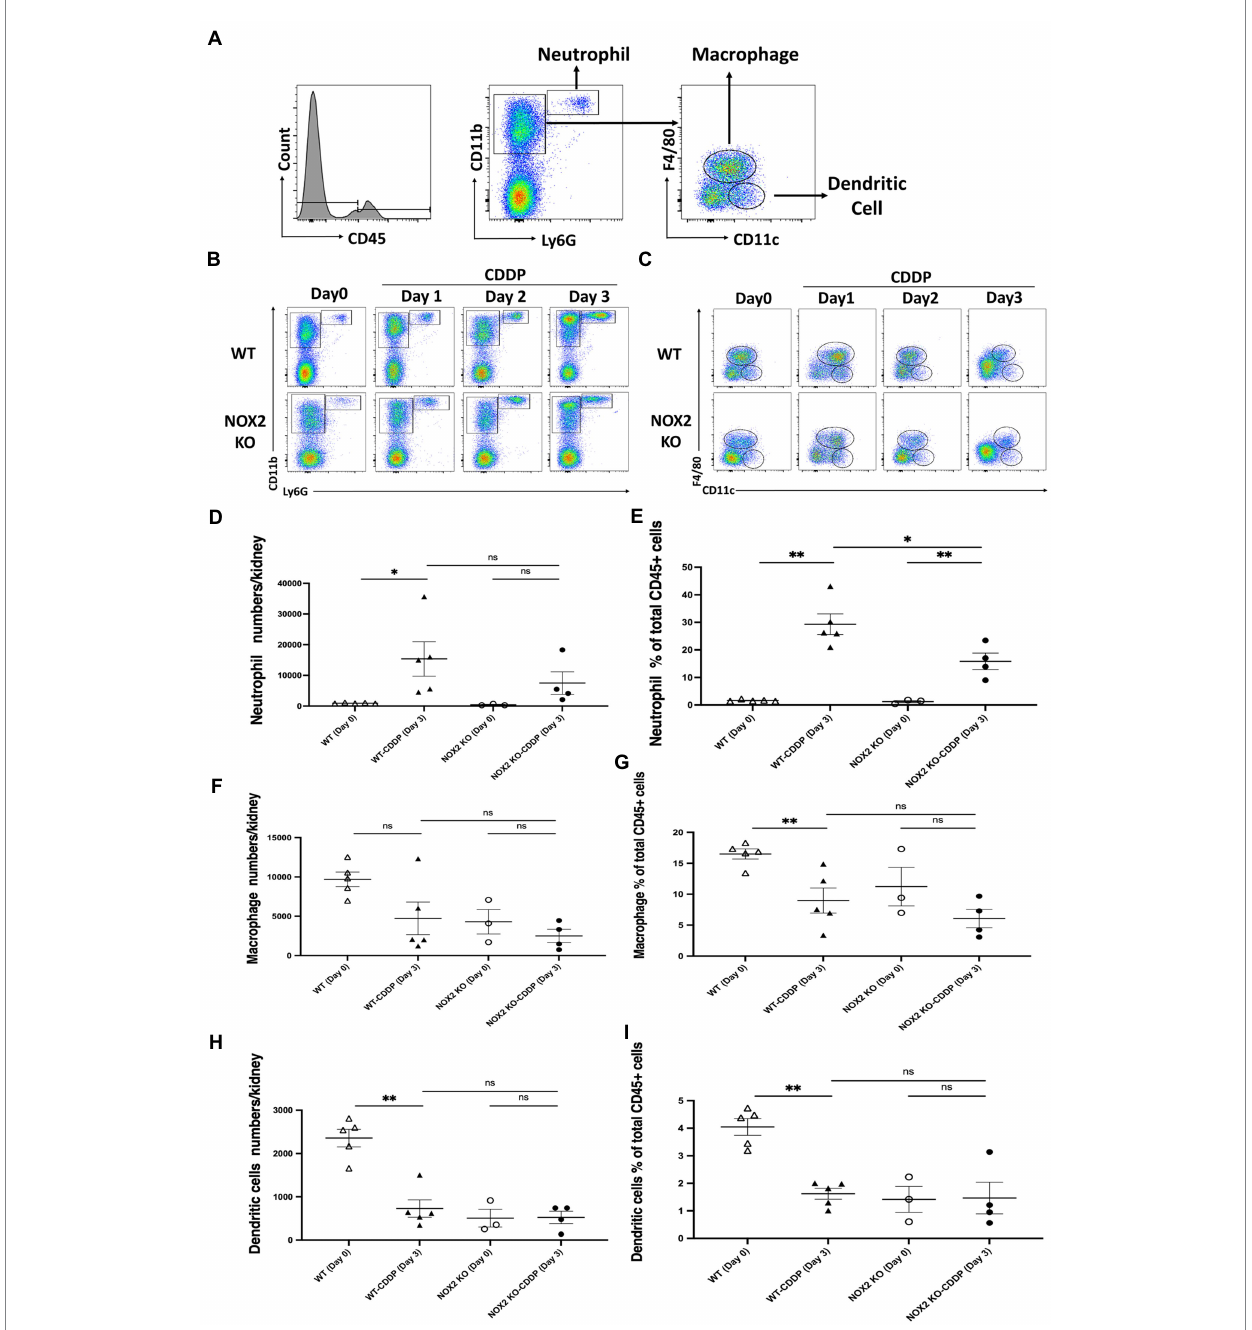
FIGURE 6 Mice with NOX2 deletion had reduced neutrophil infiltration in cisplatin-induced AKI. (A) Whole kidneys were homogenized into a single-cell suspension for flow cytometric analysis of immune cells. Hierarchical gating was performed to identify Ly6G + , CD11b + neutrophils; F4/80 + , CD11C − macrophages; and F4/80 − , CD11c + dendritic cells. (B,D,E) Neutrophil infiltration was increased on day 3 after cisplatin injection in both WT and NOX2 KO groups. However, the neutrophil percentage of total CD45 + cells was significantly reduced in the NOX2-KO CDDP group on day 3 compared to that of the WT CDDP group. (C,F–I) The percentages of macrophage and dendritic cells among total CD45 + cells were significantly reduced in the WT CDDP group on day 3 compared to the WT on day 0. However, the numbers and percentages of total CD45 + macrophage and dendritic cells were not significantly different between the WT CDDP and NOX2-KO CDDP groups on day 3. Data represent the mean ± standard error of 3–5 mice per